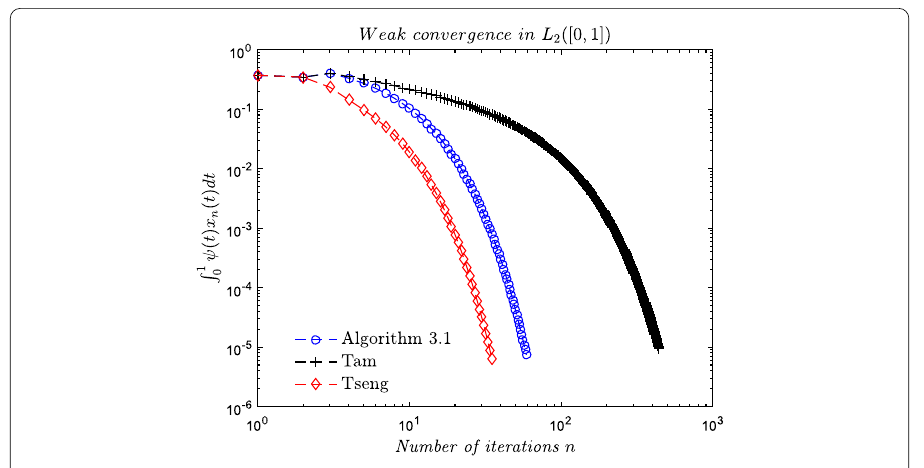
Figure 6 Example 2 with θ = 0.4 and λ n = 0.01 + (0.2) n –1